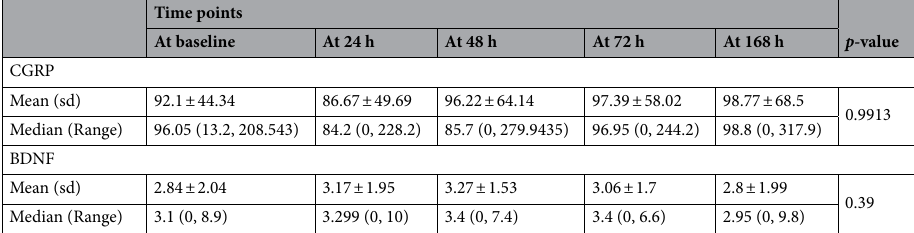
Table 2. Comparison of objective pain score – molecular pain biomarker CGRP and BDNF over time points.